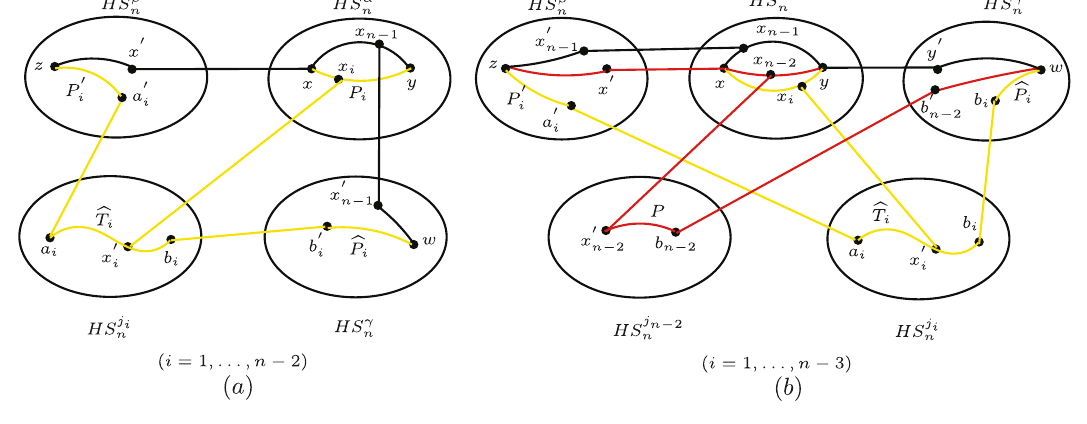
Figure 11: The illustrations of ( a ) Case 4.2.2 and ( b ) Case